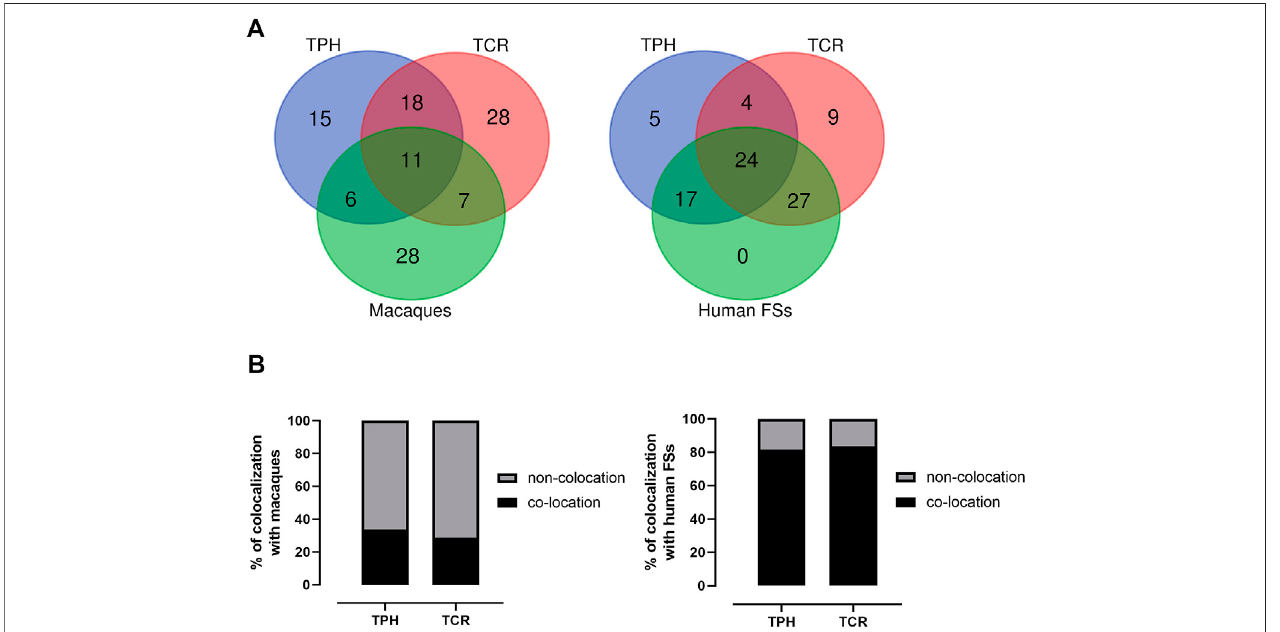
FIGURE 2 | Identi fi cation of the relationship of ECBs in TPH with those in TCR, macaque species, and fragile sites. (A) Venn Diagrams depicting overlaps of TPH ECBs between TCR and macaques, and overlaps of the co-localization of ECBs in TPH with human fragile sites compared with the co-localization of ECBs in TCR with humanfragile sites. (B) Left:quanti fi cation ofthe proportions oftheco-localization ofECBs inTPH/TCR inmacaques. Intotal, 32%ofTPH ECBs and26%ofTCRECBs were co-localizated in macaques. Right: quanti fi cation of the proportions of the co-localization of ECBs in TPH/TCR with human fragile sites. In total, 82% of TPH ECBs and 80% of TCR ECBs co-localized with human fragile